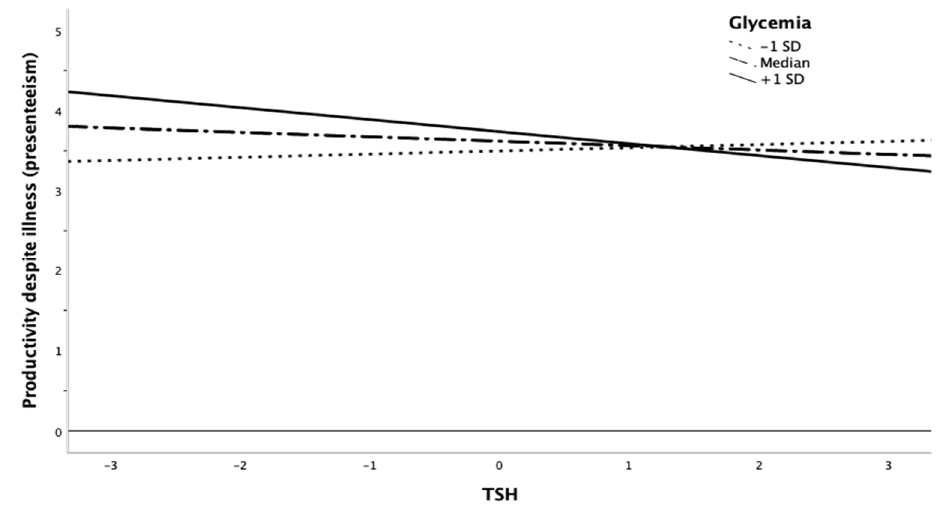
Figure 3. Interaction of TSH and glycemia predicting productivity despite illness